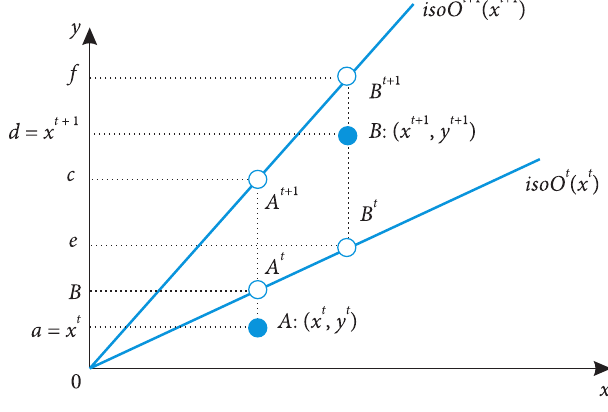
Fig. 1. The output Malmquist productivity